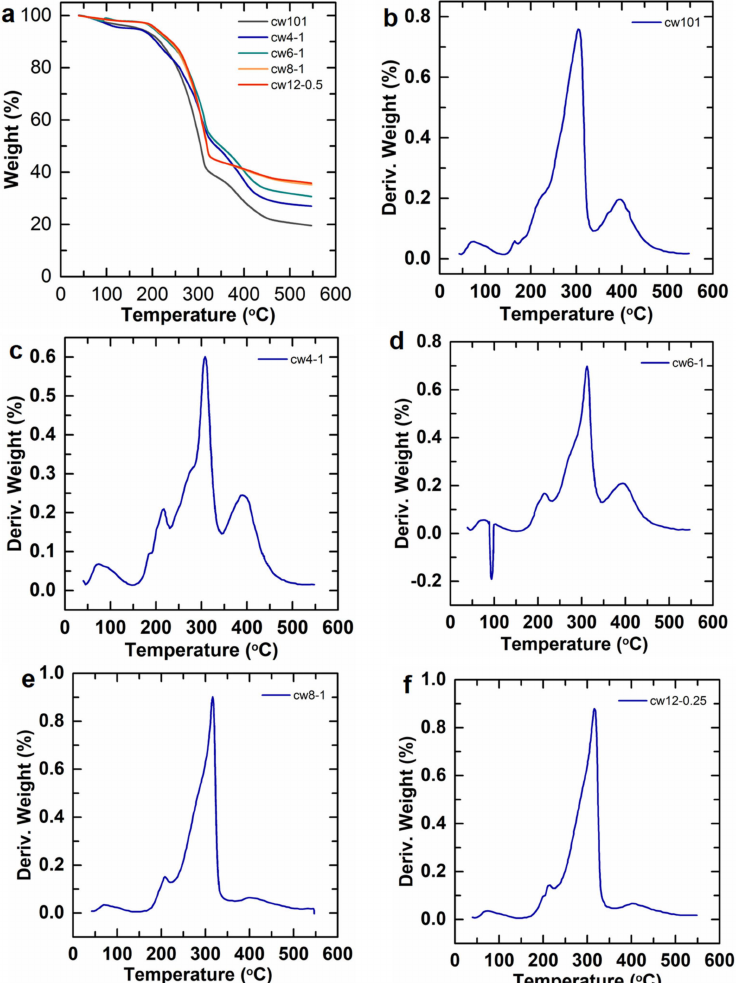
Figure 4. The TG and DTG thermal curves for HAPAM and P(AM- co -DMC). ( a ) TG thermal curves for polymers; ( b ) DTG thermal curves for cw101; ( c ) DTG thermal curves for cw4-1; ( d ) DTG thermal curves for cw6-1; ( e ) DTG thermal curves for cw8-1; ( f ) DTG thermal curves for